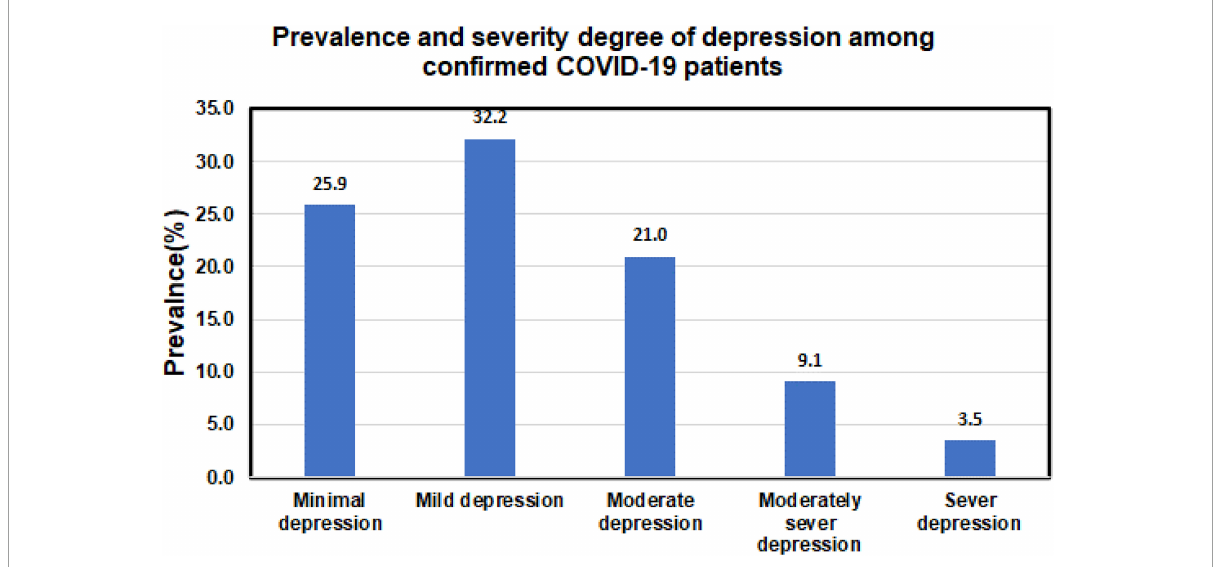
FIGURE1 Prevalence and severity degree of depression among confirmed patients with COVID-19.